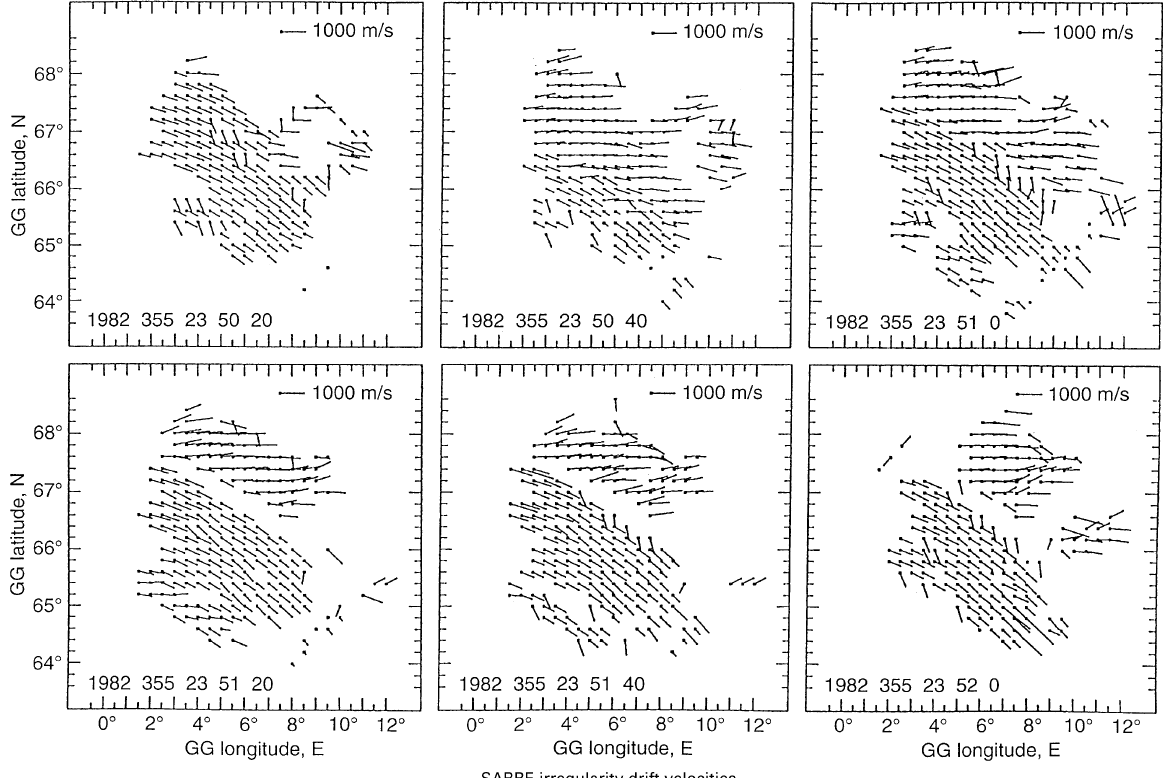
velocity that had been present. The two separate regions then move apart, the shear and gap between the two perhaps indicating the presence of a sheet of field-aligned